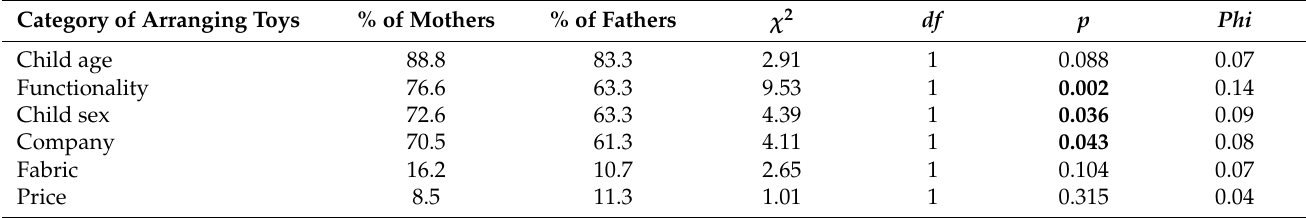
Table 1. Categories of arranging toys in stores—differences in parents’ opinions.